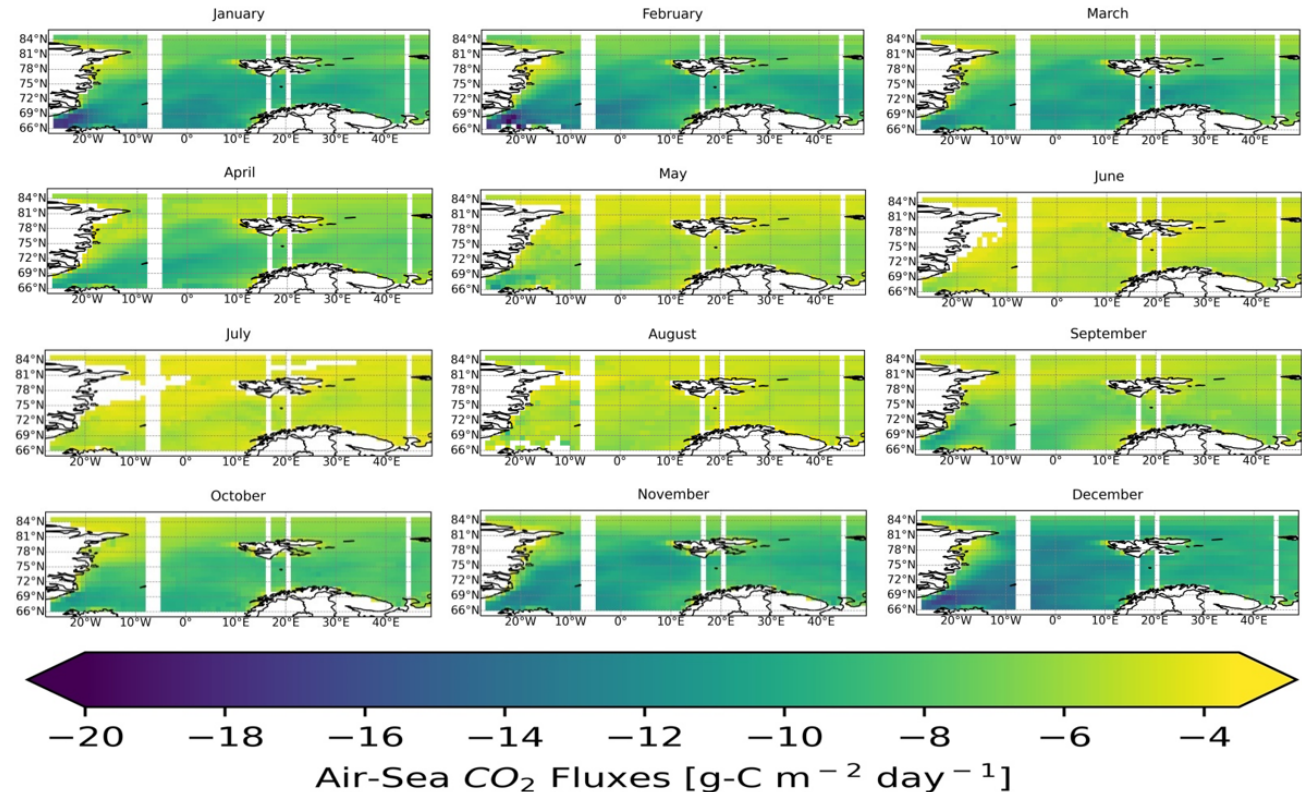
Figure 6. Five-year annual monthly mean of Air-Sea CO 2 fluxes based on pCO 2W (µatm) from Z 1 models in the European Arctic Sector.